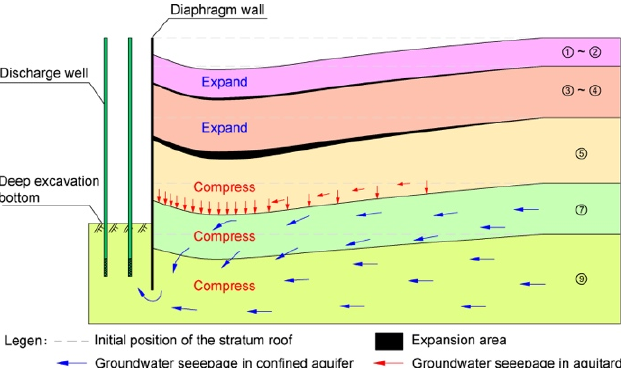
Figure 9. Conceptual schema of stratified settlement in strata.